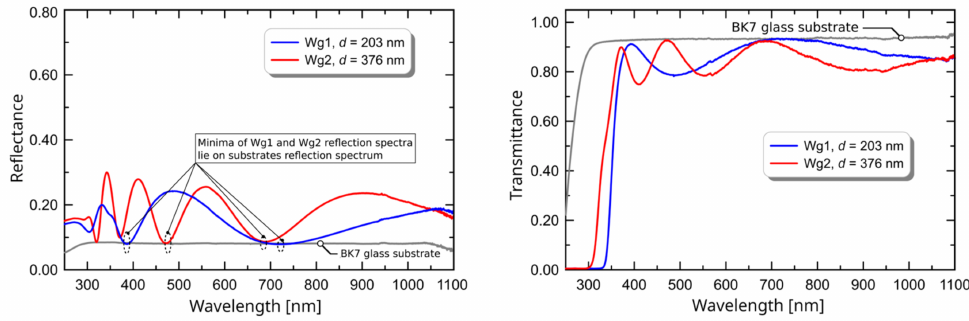
Figure 3. Measured transmission and reflectance spectra of waveguides Wg1 and